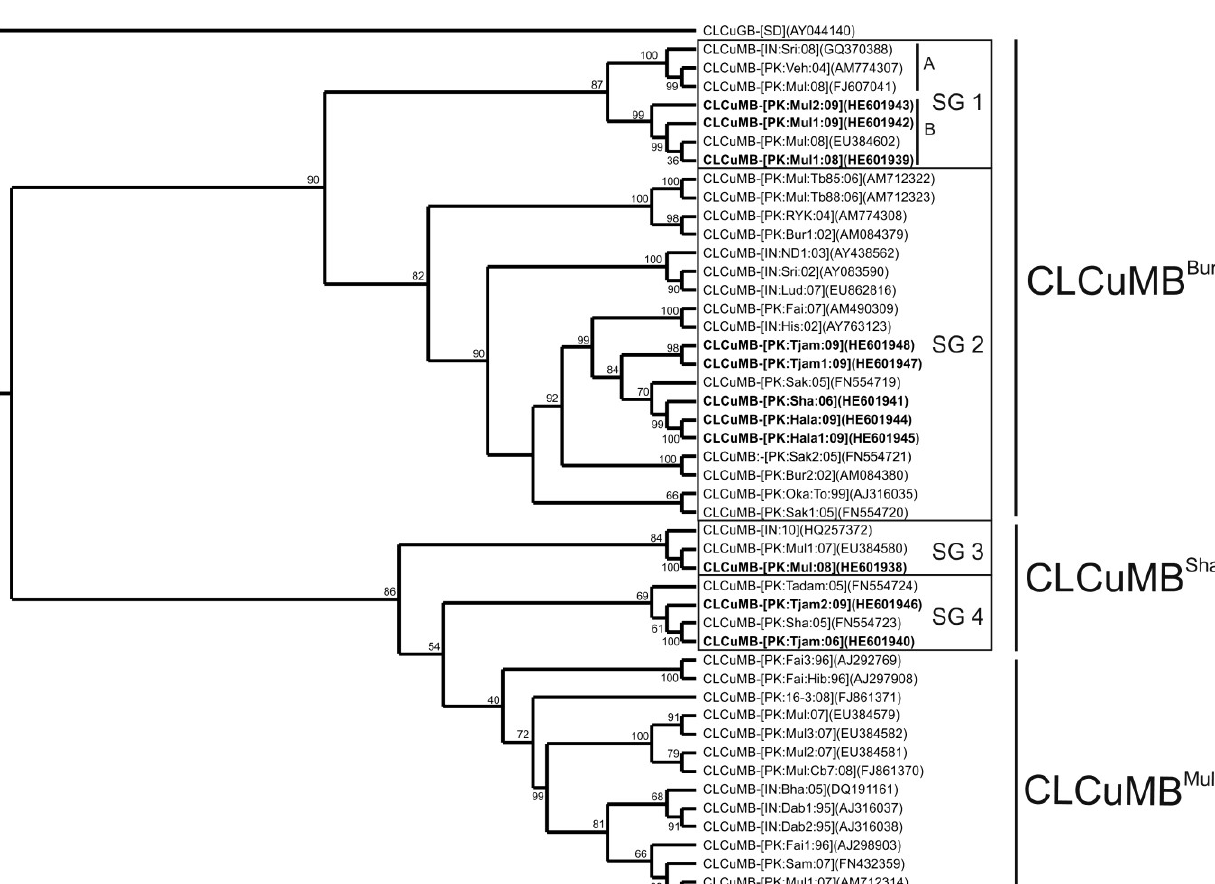
Figure 1. Phylogenetic analyses of Cotton leaf curl Multan betasatellite (CLCuMB) sequences. Shown is a neighbor-joining phylogenetic dendrogram based upon alignment of the complete nucleotide sequences of CLCuMB isolates produced as part of the study presented here (highlighted with bold text) with selected CLCuMB sequences available in the databases. The alignment was arbitrarily rooted on the sequence of Cotton leaf curl Gezira betasatellite (CLCuGB-[SD]), a distantly related betasatellite originating from Sudan, as an out group. In each case, the isolate descriptor and accession number is given. Numbers at the nodes are percentage bootstrap confidence values (1000 replicates). The recombinant CLCuMB Bur , the recombinant CLCuMB Sha and non-recombinant CLCuMB Mul isolates are indicated. The subgroups (SG) are discussed in the